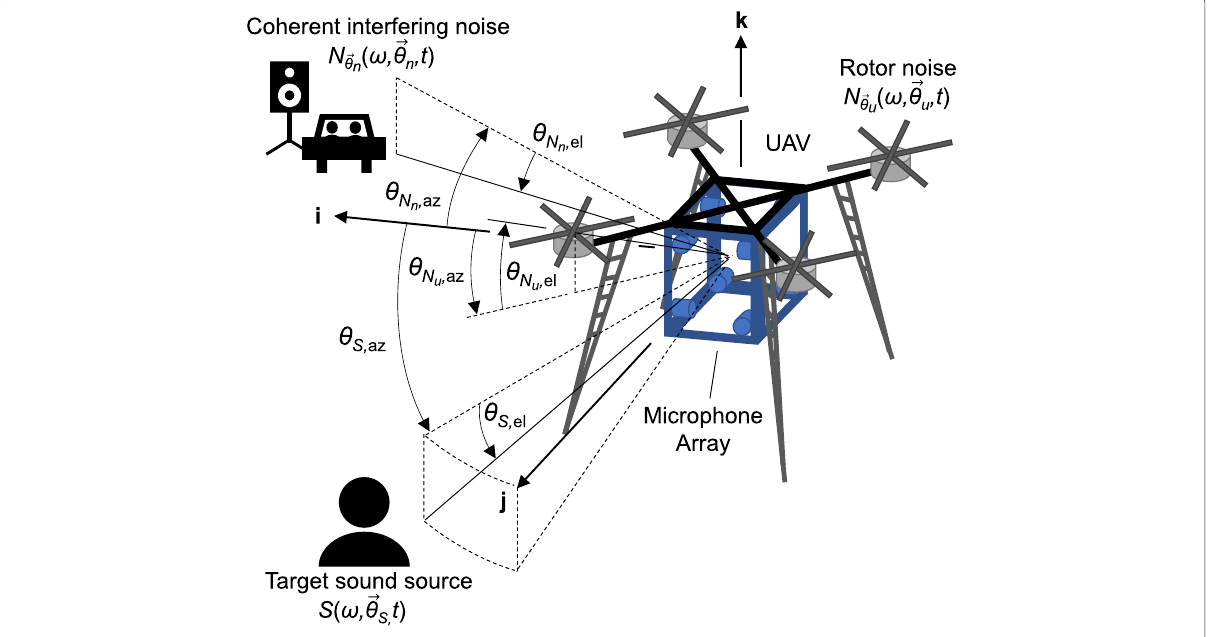
Fig. 1 Overview of problem setup for sound source localisation using